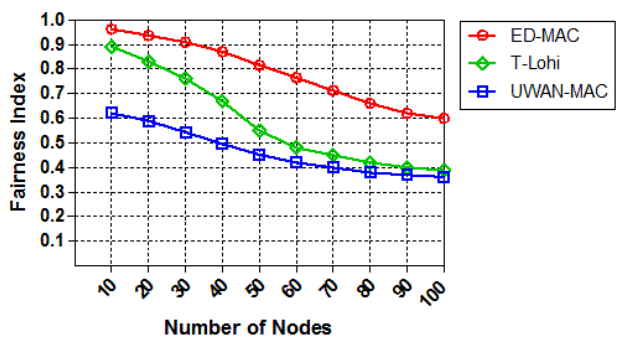
Figure 18. Fairness vs. node